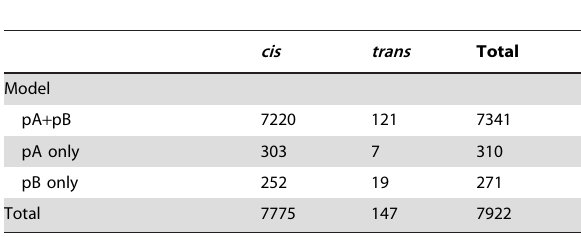
Table 1. Numbers of cis - and trans -eQTL mapped for different